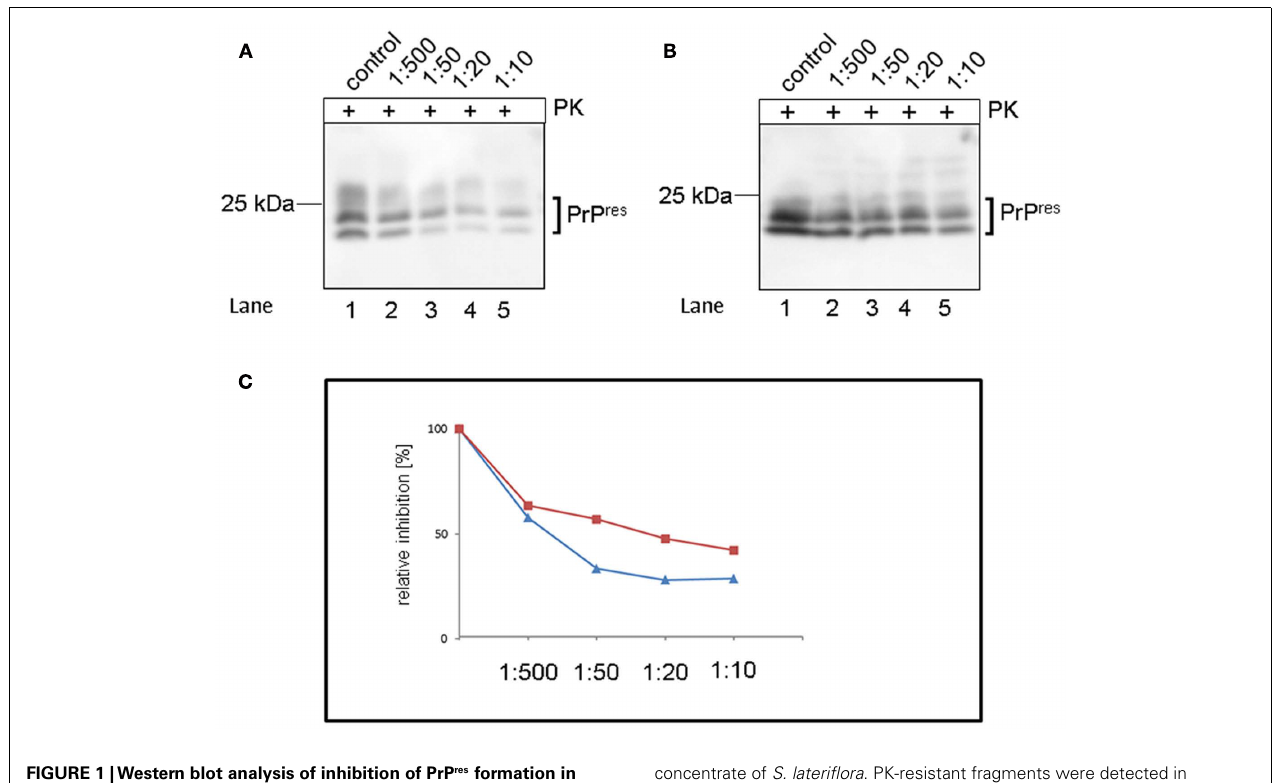
FIGURE 1 |Western blot analysis of inhibition of PrP res formation in scrapie-infected cells by tea concentrate of S. lateriflora . (A) Tea concentrate of S. lateriflora inhibits PrP res formation in ScN 2 A-cells. Lane 1 shows PK-resistant fragments of the untreated control, lanes 2–5 a sample incubated with increasing concentrations of tea concentrate of S. lateriflora : 1:500 (lane 2), 1:50 (lane 3), 1:20 (lane 4), and 1:10 (lane 5). (B) Inhibition of PrP res formation in SMB-cells by tea